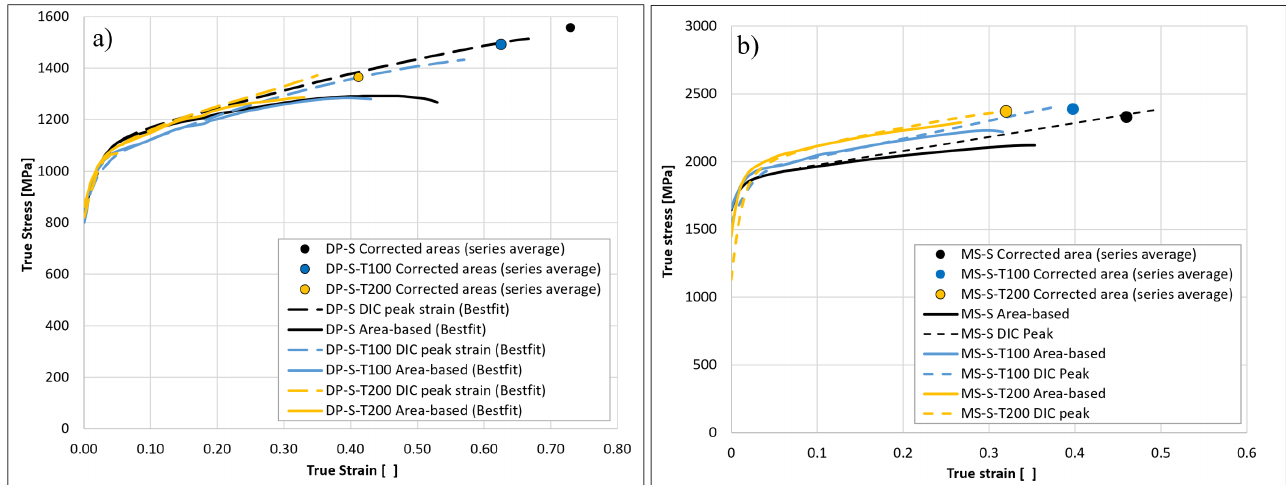
Figure 14. Thermal effect at static rates for the DP ( a ) and MS ( b ) materials.